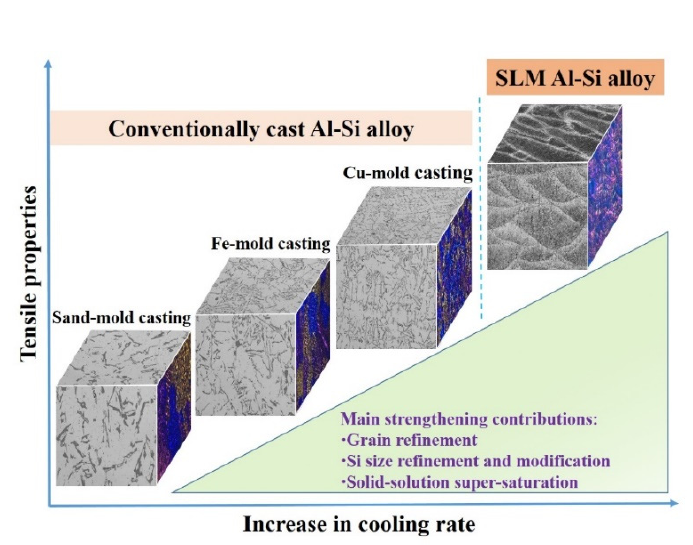
Figure 12. Schematic illustration showing the relationships among preparation method, microstruc- ture and mechanical properties.